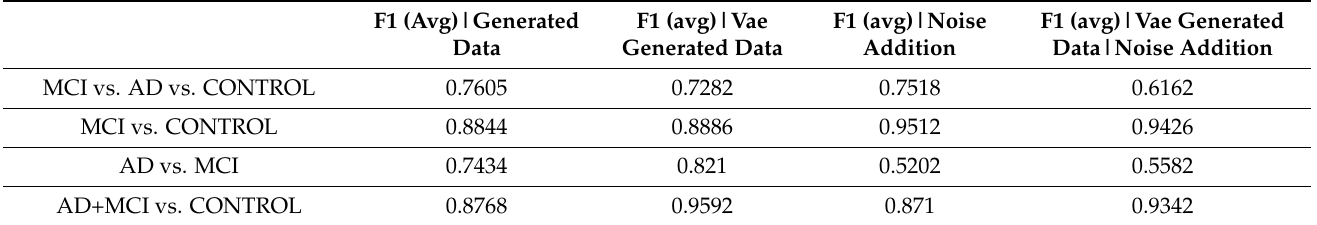
Table 4. Average accuracy and F1Score criteria for 50 trials for different time intervals. Results for 10 s (accuracy).